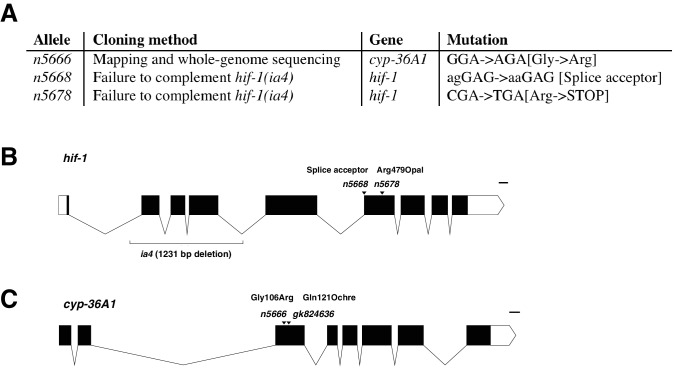
A screen for suppressors of the egl-9(lf) egg-laying defect.(A) Summary of three cloned alleles from a suppressor screen of the egl-9(lf) egg-defect. (B) Gene diagram of hif-1; isoform F38A6.3b is shown. The ia4 deletion allele was generated by deletion screening (Jiang et al., 2001). Scale bar, 100 bases. (C) Gene diagram of cyp-36A1. The gk824636 allele is from the Million Mutation Project (Thompson et al., 2013). Scale bar, 100 bases.